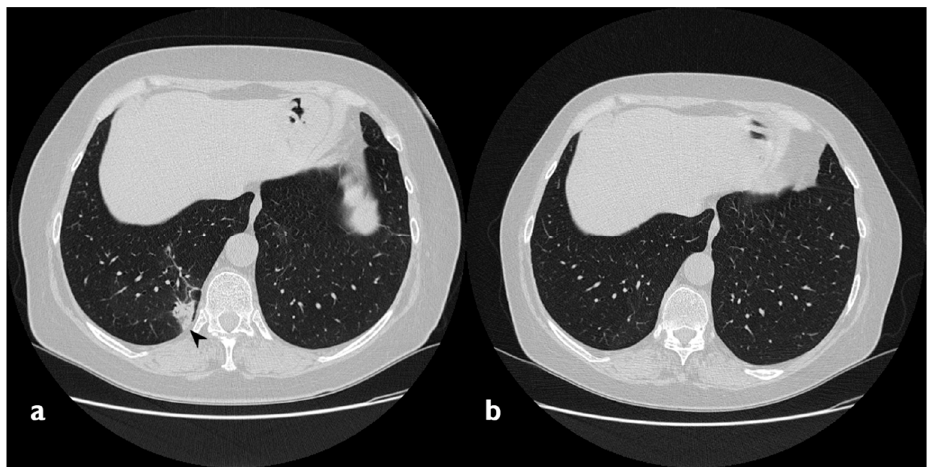
Figure 8. On the left: baseline HRCT ( a ); subpleural consolidation in the right lower lobe. On the right ( b ): HRCT after 11 months of steroid therapy shows a disappearance of the consolidation.